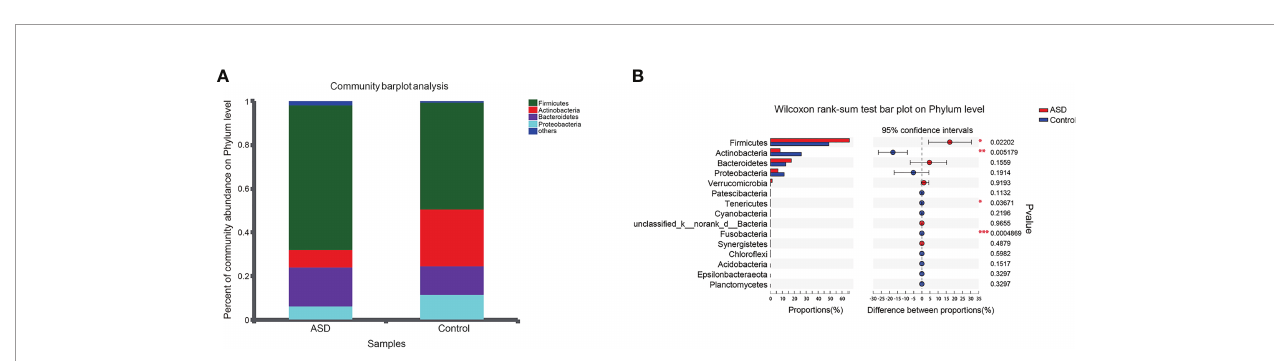
FIGURE 5 | Relative abundance of fecalmicrobiota in each sample at the phylum level (red: ASD group; blue: control group). (A) The community abundance of gut microbiota on phylum level; (B) The difference of gut microbiota between ASD and control group on phylum level. *P < 0.05, **P < 0.01 and ***P < 0.001.